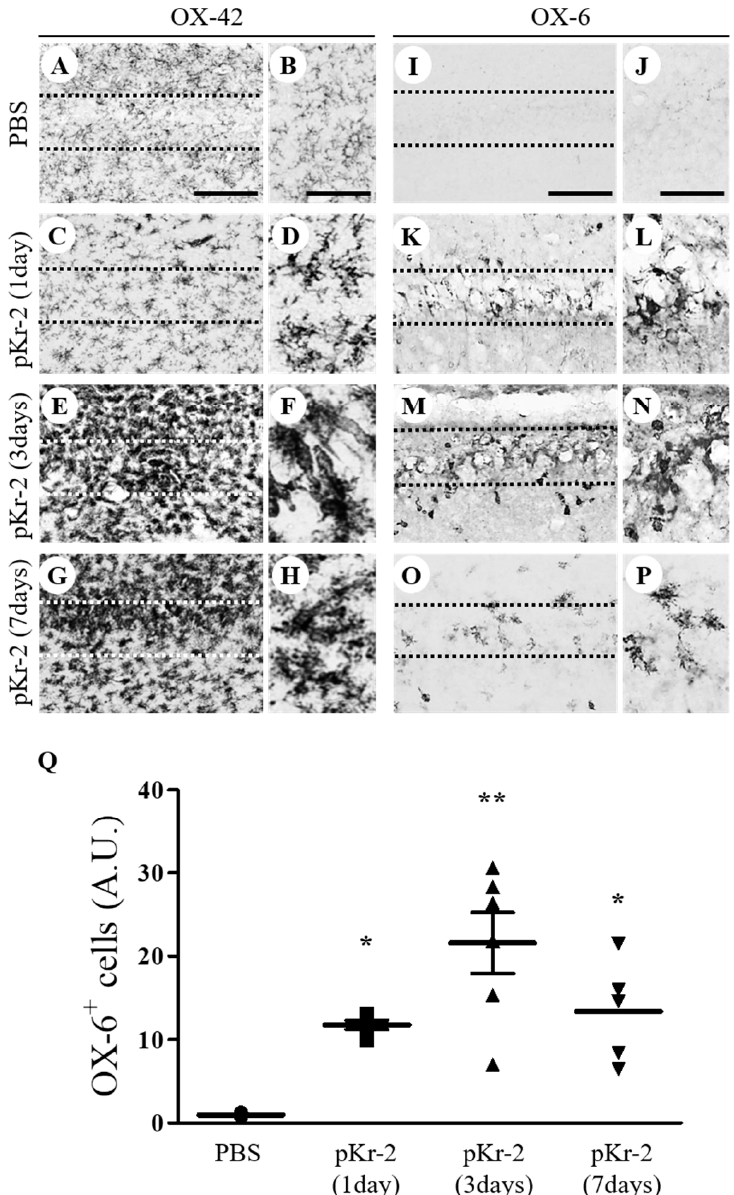
Figure 1. Prothrombin kringle-2-induced microglial / macrophages activation in the CA1 area of the hippocampus in vivo. Phosphate-bu ff ered saline (PBS) ( A , B , I , J ) as a control or prothrombin kringle-2 (pKr-2; C – H , K – P ; 48 µ g / 4 µ L) was unilaterally injected into the CA1 layer of rat hippocampus. Animals were transcardially perfused at indicated time points and brain tissues were prepared for immunohistochemical staining. Every sixth serial sections were selected and immunostained with OX-42 (complement receptor 3, CR3; A – H ) to identify microglia / macrophages and neutrophils or OX-6 (major histocompatibility complex class II; I – P ) to identify activated microglia at 1 day ( C , D , K , L ), 3 days ( E , F , M , N ) and 7 days ( G , H , O , P ) after intrahippocampal injection of pKr-2. ( B , D , F , H , J , L , N and P ) show higher magnifications of ( A , C , E , G , I , K , M and O ), respectively. Scale bars, 100 µ m ( A , C , E , G , I , K , M and O ), 100 µ m ( B , D , F and H ) and 50 µ m ( J , L , N and P ). ( Q ) Quantification of OX-6 + cells in the CA1 layer of pKr-2-injected hippocampus. * p < 0.01, ** p < 0.001 significantly di ff erent from PBS. mean ± SEM; n = 5 to 7 in each group, ANOVA and Newman–Keuls analysis. Note the morphological changes from resting (small cell bodies with ramified processes) to activated state (large cell bodies with short processes) in the pKr-2-injected CA1 layer of hippocampus, compared with the PBS-injected control.